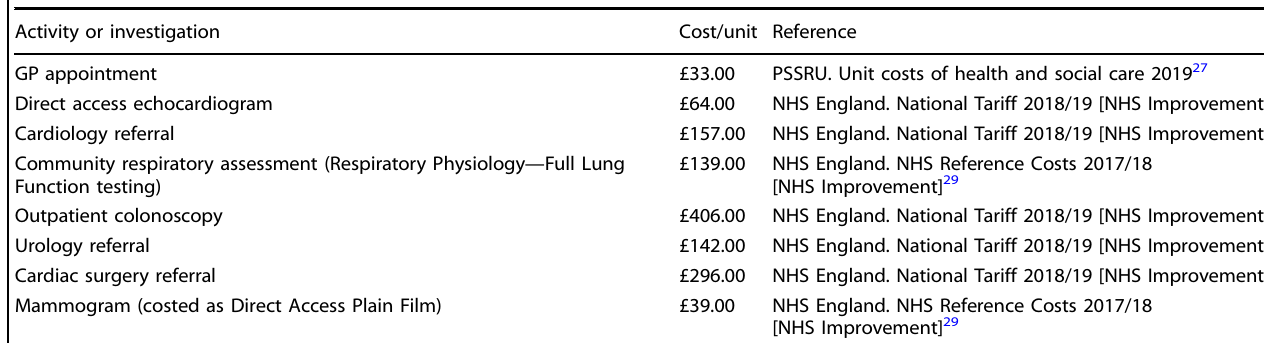
Table 4. Cost inputs and sources for primary care